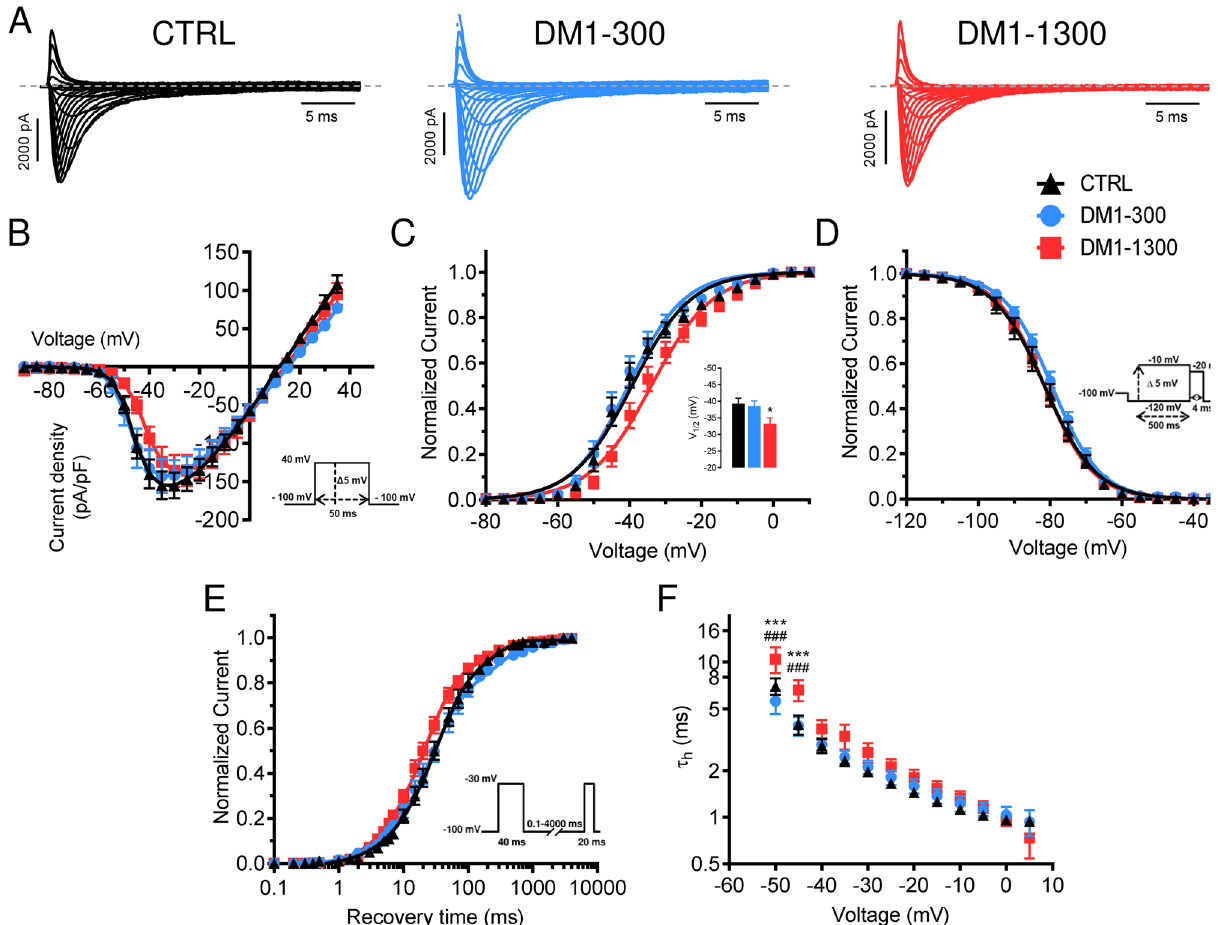
Figure 3. Sodium channels exhibit electrophysiological modifications in patient-specific iPSC-CMs. ( A ) Representative sodium currents recorded in CTRL and DM1 iPSC-CMs. The dashed line represents zero current. ( B ) Normalized current/voltage relationships recorded in CTRL (n = 12), DM1-300 (n = 11), and DM1-1300 (n = 13) iPSC-CMs. Sodium current densities were measured by normalizing current amplitudes to membrane capacitance and were plotted against voltage. ( C ) Steady-state activation of sodium currents from CTRL and DM1 iPSC-CMs. Activation curves were generated using a standard Boltzmann distribution: G(V)/ G max = 1/(1 + exp(- (V-V 1/2 )/k)). Inset shows graph of V 1/2 . ( D ) Steady state inactivation of CTRL (n = 12) DM1- 300 (n = 9) and DM1-1300 (n = 12). Inactivation currents were obtained using 10-ms test pulses to – 10 mV after a 500-ms pre-pulse to potentials ranging from – 140 to – 20 mV. The inactivation values were fitted to a standard Boltzmann equation: I(V)/I max = 1/(1 + exp((V − V 1/2 )/k)) + C. ( E ) Recovery from inactivation values recorded from CTRL (n = 9), DM1-300 (n = 9), and DM1-1300 (n = 9) iPSC-CMs. The cells were depolarized to – 30 mV for 40 ms from a holding potential of – 100 mV to inactivate the Na + channels. Test pulses were then applied to – 30 mV for 20 ms to measure current amplitudes, with an interval ranging from 0.1 to 4000 ms. The resulting curves were fitted with a two-exponential equation: (A fast (1 – exp(− t/τ fast )) + Aslow(1 − exp(− t/τ slow )) + C). ( F ) The time constants of fast inactivation decay were plotted as a function of voltage for the CTRL and DM1 iPSC- CMs. The time constants were obtained using a single exponential function: (A(exp(− t/τ) + C). Bars indicate SEM. *p < 0.05, ***p < 0.001 (CTRL vs DM1-1300) and ### p < 0.05 (DM1-300 vs DM1-1300) by ANOVA